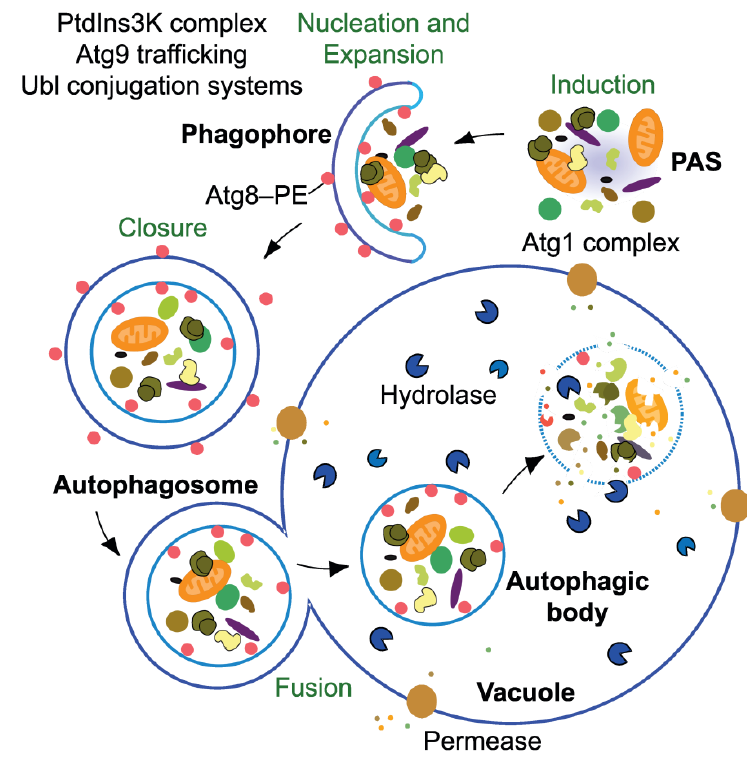
FIGURE 1: The mechanistic features of yeast au- tophagy. Initiation of autophagy requires the for- mation of the Atg1 kinase complex at the PAS to allow the recruitment and activation of other Atg proteins. In yeast there is typically one PAS per cell, but the precise nature of this site is not well de- fined; the PAS may literally become a phagophore, making it a dynamic structure that continuously reforms. Next, the PtdIns3K complex translocates to the PAS to begin the nucleation process that will catalyze further movement of additional Atg pro- teins to this site. Ubl proteins such as Atg8–PE participate in cargo recognition during selective types of autophagy, and also play a role in deter- mining the size of the autophagosome. Membrane delivery to the phagophore allows expansion and maturation into an autophagosome. This process also employs the transmembrane protein